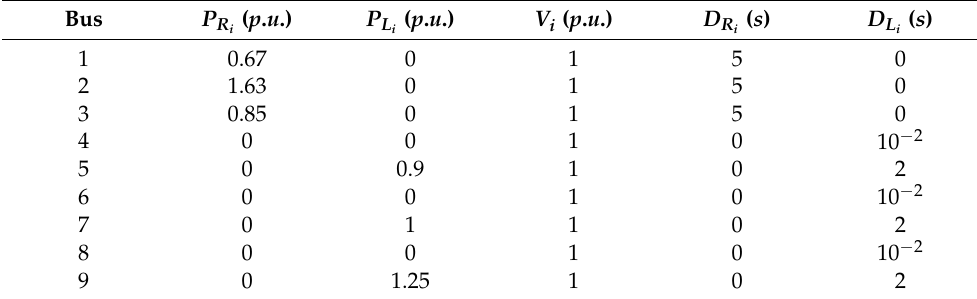
Table 2. BUS generation and load parameters of IEEE 9 test